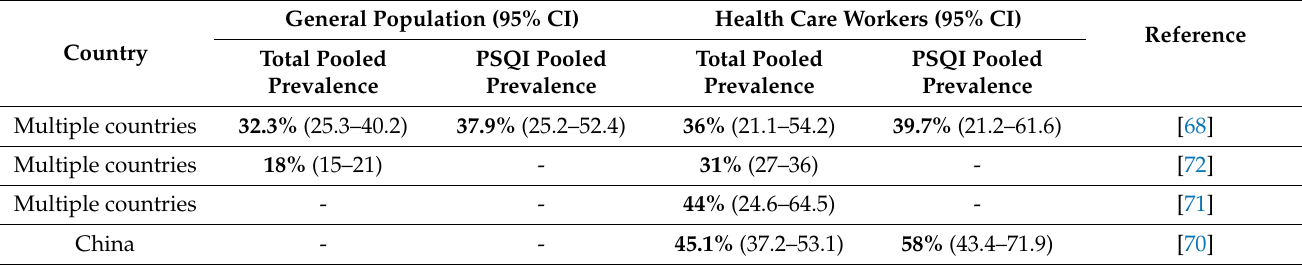
Table 4. Comparison of the prevalence of sleep deficiencies * between the general population and health care workers during the